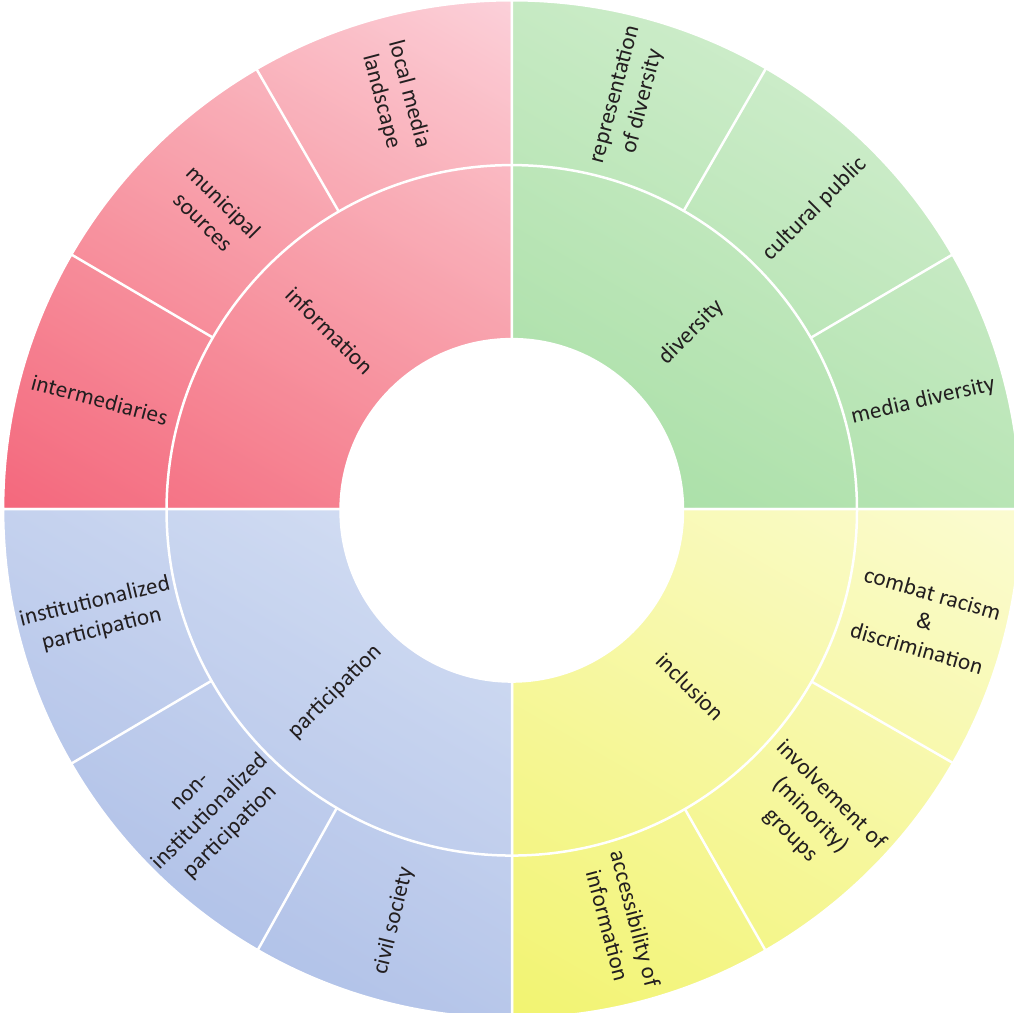
Figure 1. Monitoring the local public sphere: Dimensions and